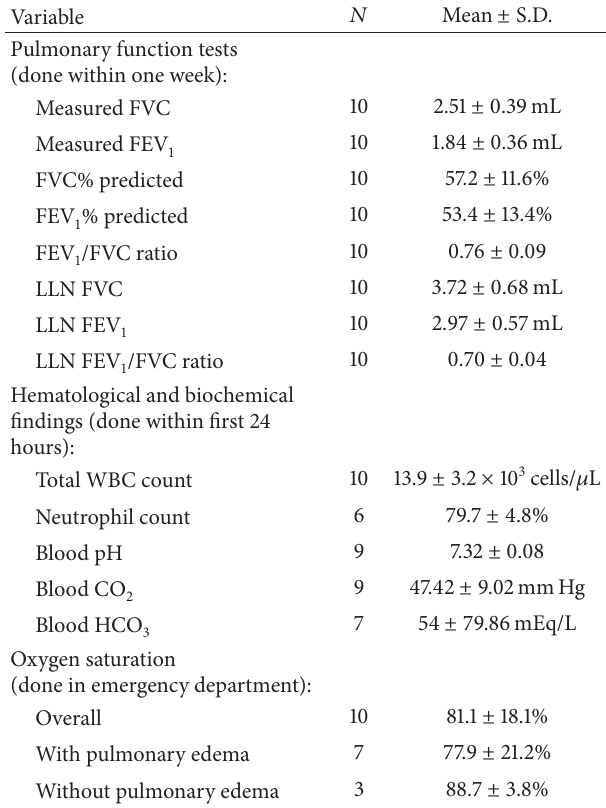
Table 4: Mean and standard deviation of pulmonary function parameters, hematological and biochemical findings, and oxygen saturation. 𝑁 Mean ±